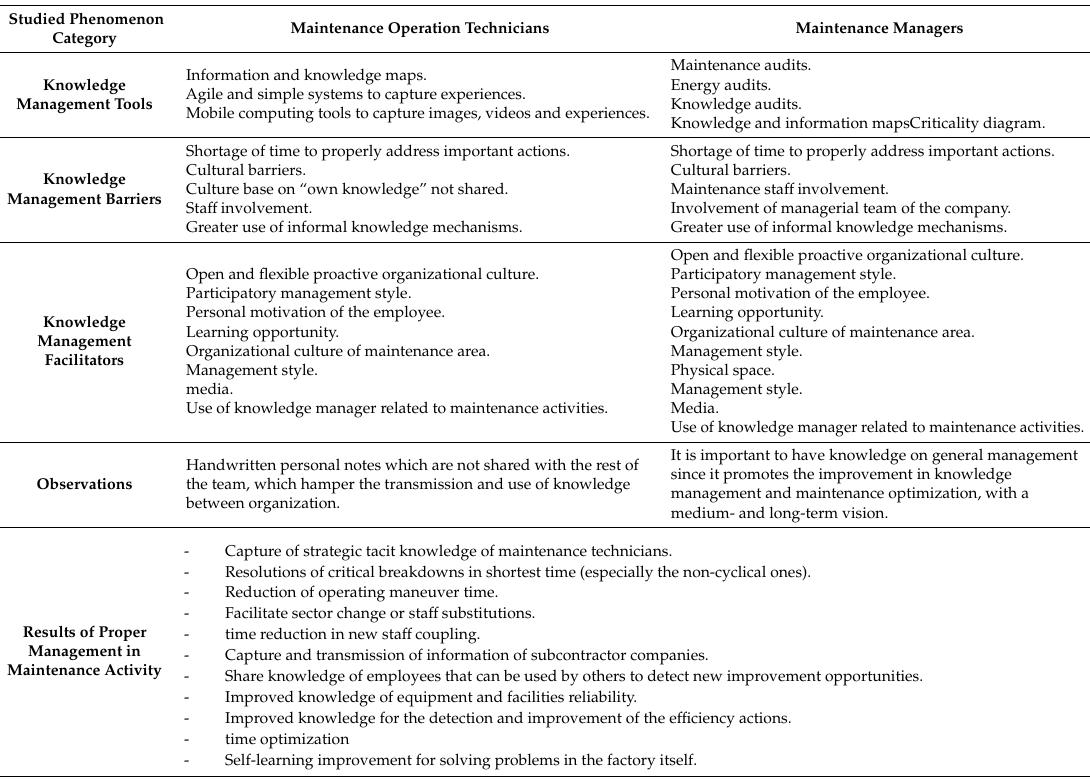
Table 3. Tools, barriers and facilitators in KM in maintenance